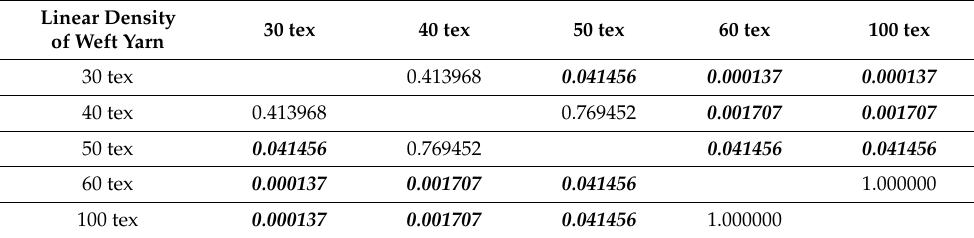
Table 9. The results of the Tukey’s test for the